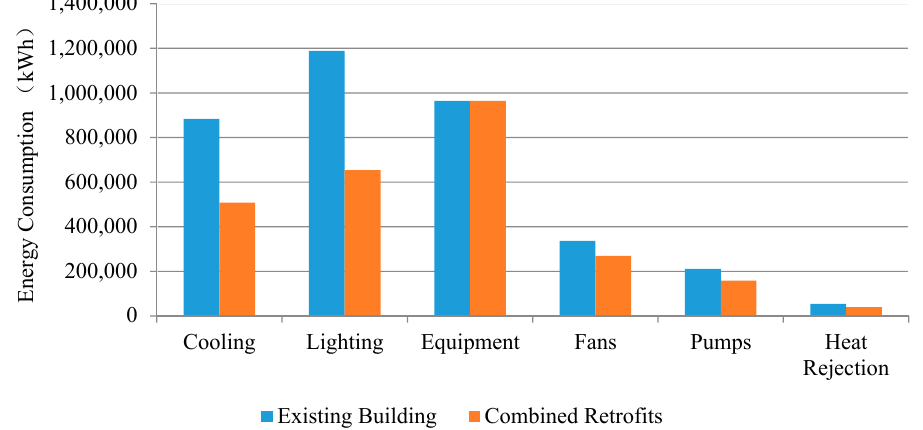
Figure 9. Annual energy consumption before and after the combined retrofits.